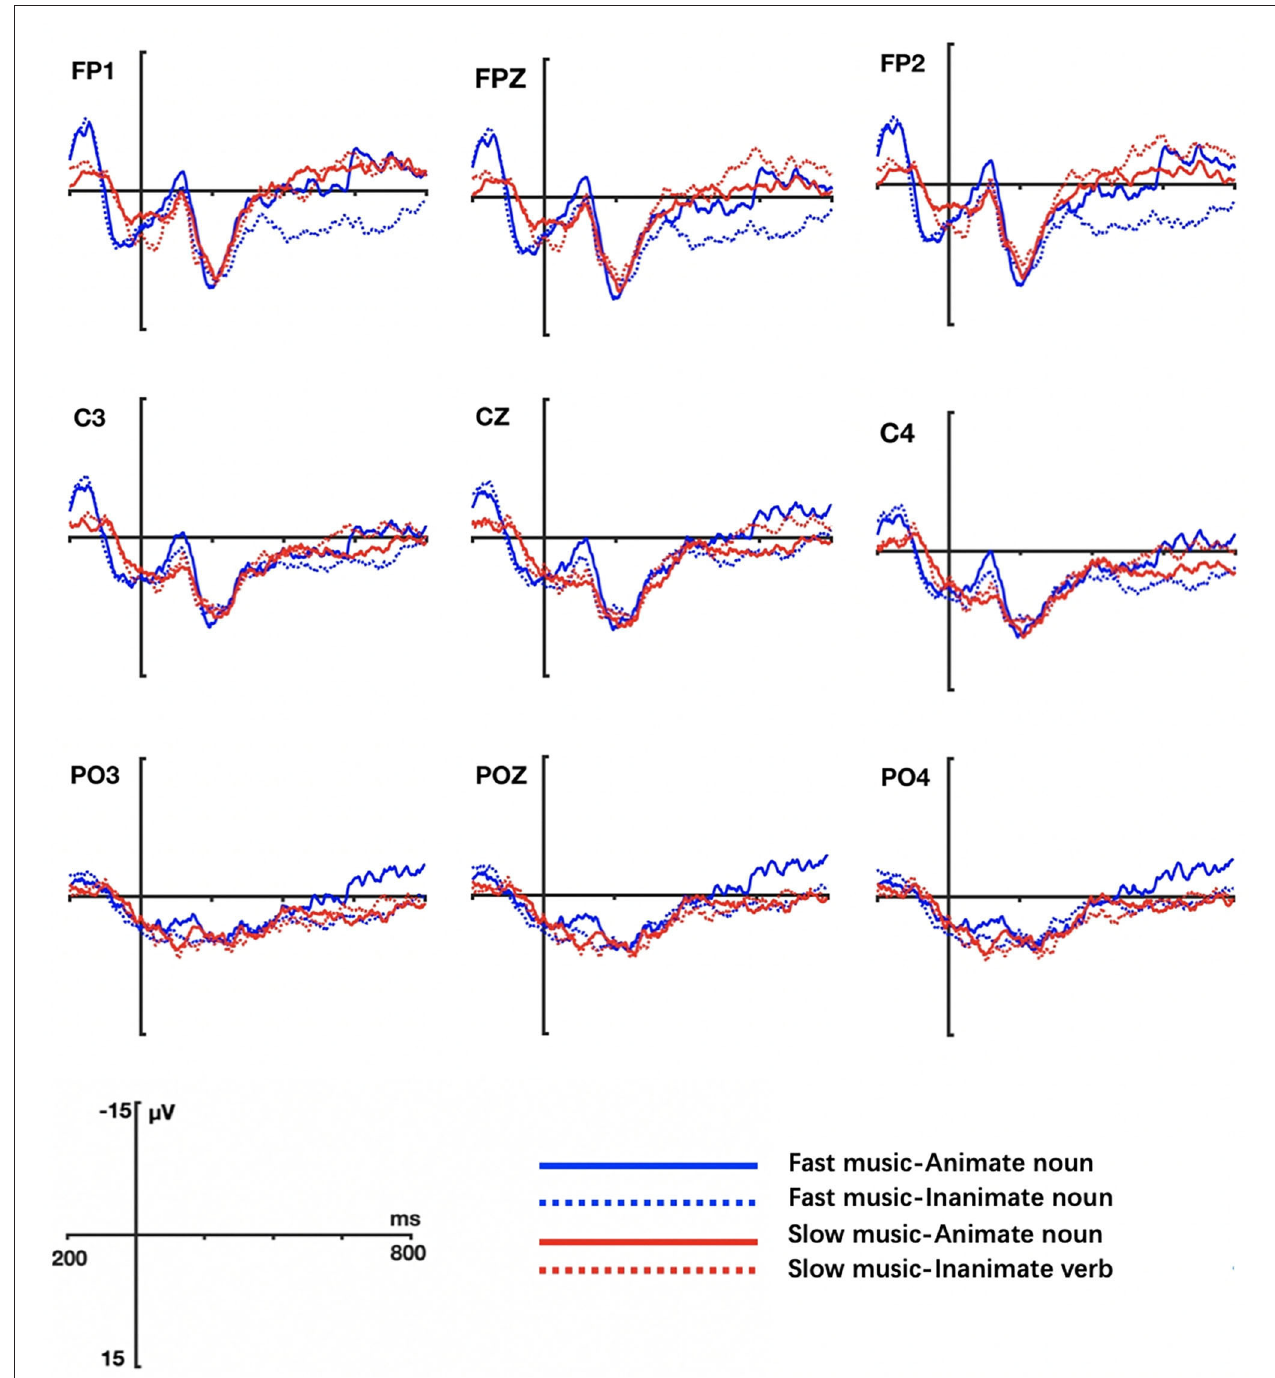
FIGURE 7 | Grand ERP averages elicited by animate and inanimate nouns in tempo-without-change music priming conditions (Task 4).